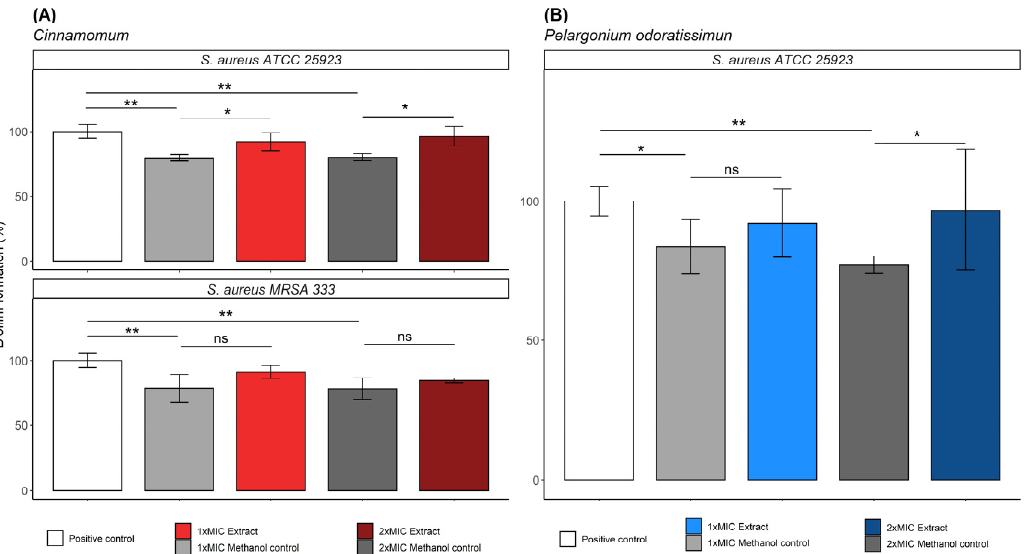
Figure 1. Representative illustration of the biofilm inhibition assays by extract plants used in the herbal infusion horchata. ( A ) Evaluation of the antibiofilm activity of Cinnamomum sp. extract against S. aureus and MRSA 333. ( B ) Evaluation of the antibiofilm activity of Pelargonium odoratissimum extract against S. aureus . All statistical analyses ( p -values) were analysed using a nonparametric Mann–Whitney test (95% confidence interval) for comparison between biofilm formation values, where: * p -values < 0.05; ** p -values < 0.01; and ns: nonsignificant p -value.